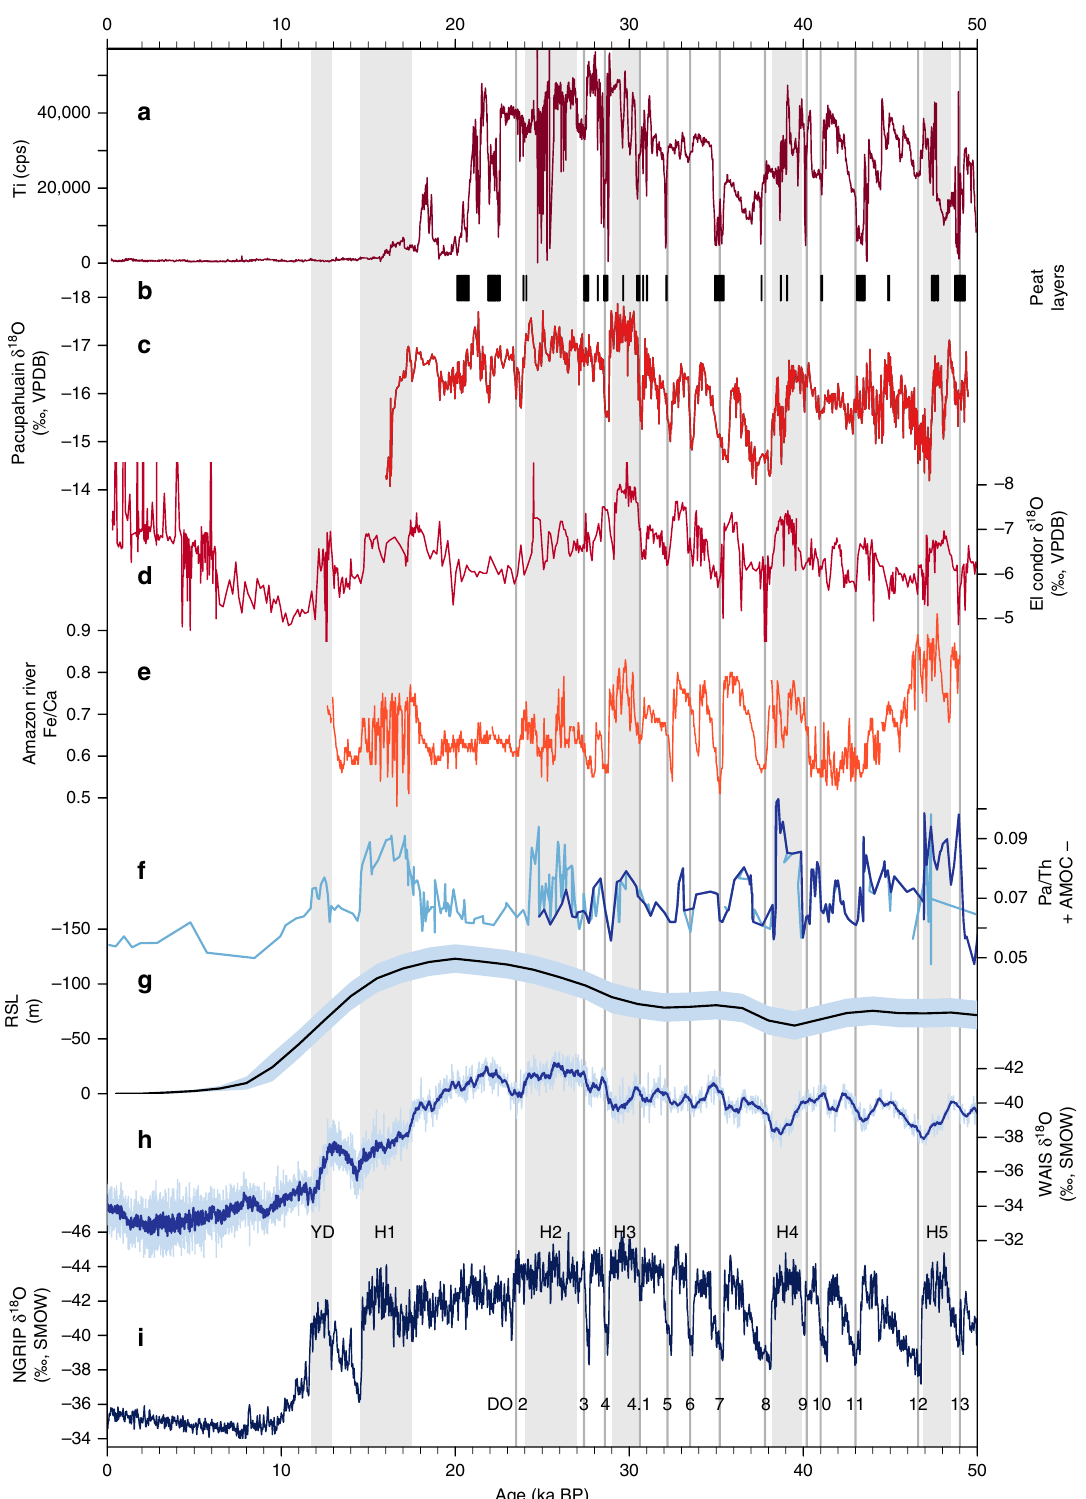
Fig. 3 Comparison of regional and global proxy paleoclimatic records. a Junín glaciation (Ti from Fig. 2a). b Junín low stands (peat layers). c Pacupahuain speleothem δ 18 O 5 . d El Condor speleothem δ 18 O 8 . e Amazon Discharge 9 . f Atlantic Meridional Overturning Circulation (AMOC) strength (dark blue curve is Pa/Th data reported in (1)), and the light blue curve is a compilation of previously reported Pa/Th records as presented in (1). g Relative sea level 37 . h WAIS Divide ice core δ 18 O 38 . i NGRIP ice core δ 18 O 20,21 . Vertical gray boxes denote the Younger Dryas and Heinrich stadials H1 – H5, and numbered vertical lines are Dansgaard – Oeschger (DO) warming events 2 –